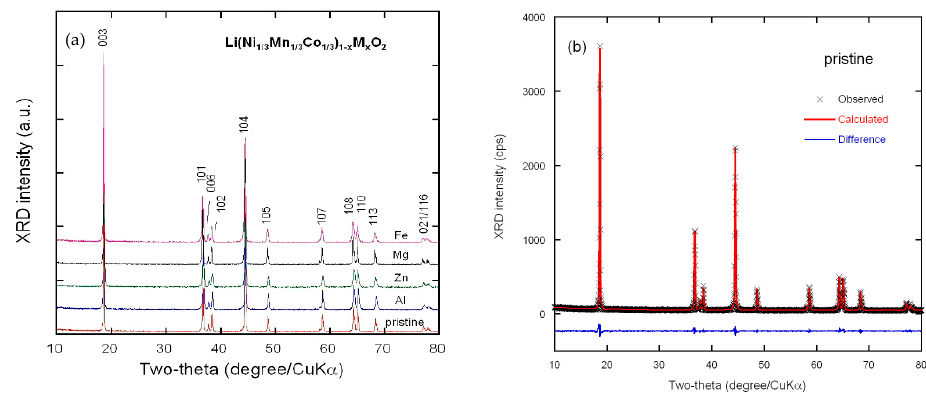
using this model, taking into account such a cation